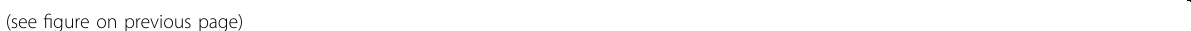
Fig. 3 MSCs-induced megakaryocytic differentiation through restoring MPL expressions of CML cells. A K562 cells (left) and LAMA-84 cells (right) were co-cultured with MSCs, respectively. The expression levels of MPL were measured by RT-qPCR ( n = 3). B K562 cells were co-cultured with MSCs for 48 h, the expression of upstream transcription factors of MPL in K562 cells was assessed by RT-qPCR ( n = 3). C K562 cells were treated with MSCs for 48 h, the cell-surface expression of MPL was measured by western blotting. ATPase Na + /K + beta 2 (ATPase) was used as a loading control for membrane fraction. D K562 cells were cultured alone or co-cultured with MSCs for the indicated time. MPL levels were measured by fl ow cytometric. E K562 cells were transfected with siRNA negative control (K562 si-NC) or MPL-siRNA (K562 si-MPL). The K562 si-NC or K562 si-MPL cells were co-cultured with MSCs. After 48 h, the cell surface protein CD41 and CD42b in K562 cells were analyzed by fl ow cytometric. F The phosphorylation status of correlated signaling pathways was determined by western blotting after treatment with MSCs for 48 h. GAPDH was used as a loading control. G The expression levels of THPO in MSCs were assessed by RT-qPCR ( n = 3). H K562 cells were overexpressed MPL (OE-K562), the relative mRNA levels of differentiation genes were assessed by RT-qPCR after treatment with El for 48 h. I CD41 and CD42b levels of OE-K562 cells were measured by fl ow cytometric after treatment with El for 48 h. All statistical data in this fi gure represent the mean ± SEM (* P <0.05, ** P <0.01, *** P <0.001, ns, not signi fi cant, by one-way ANOVA in A , D , and G by Student ’ s t test in B , C , E , H , and I